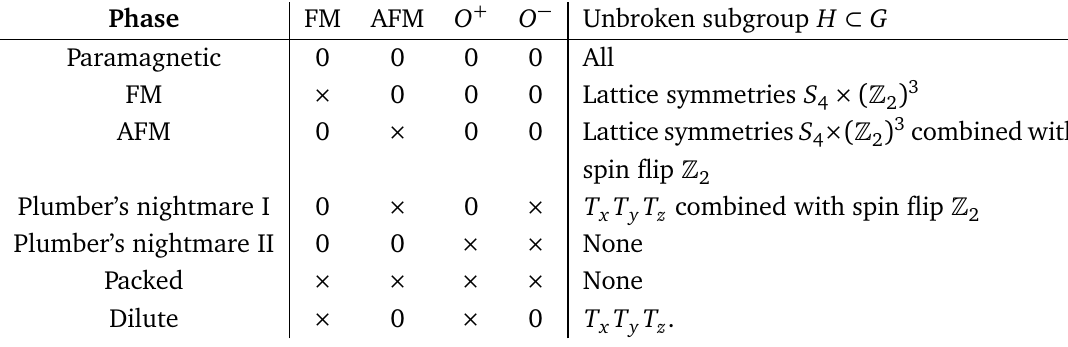
× ( (cid:90) ) 3 4 2 × ( (cid:90) ) 3 combined with 4 2 spin flip (cid:90) 2 T T combined with spin flip (cid:90) x y z 2 T T x y z